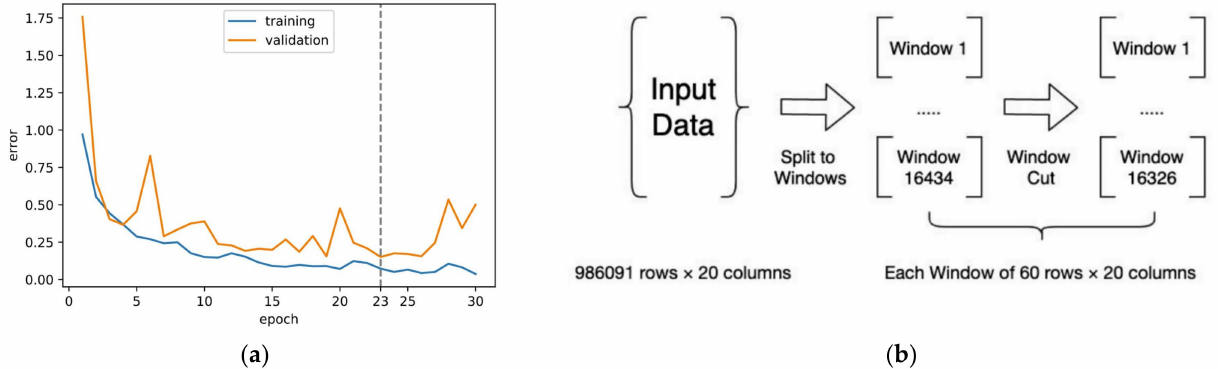
Figure 4. Model training: ( a ) the training and validation error over the epoch, the model converged at epoch 23 and became overfitting afterward, ( b ) window